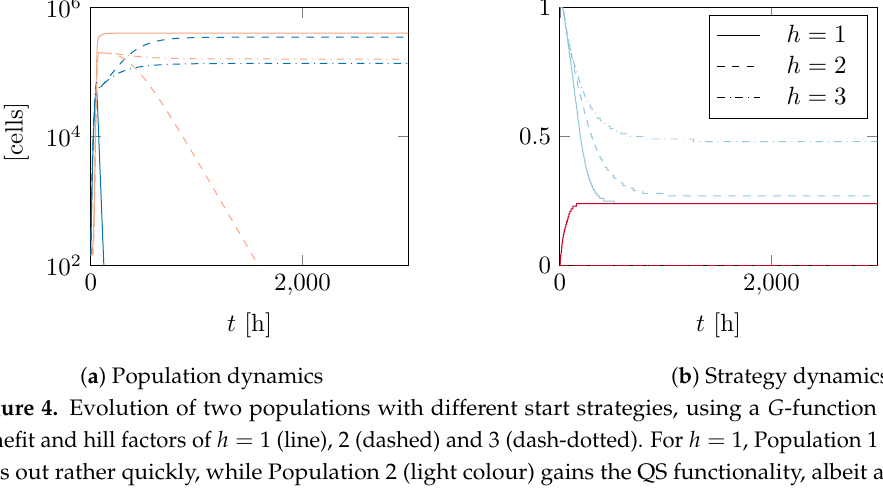
Figure 4. Evolution of two populations with different start strategies, using a G -function with private benefit and hill factors of h = 1 (line), 2 (dashed) and 3 (dash-dotted). For h = 1, Population 1 (dark colour) dies out rather quickly, while Population 2 (light colour) gains the QS functionality, albeit at a low level, and remains at a stable population level. If h = 2, Population 1 reduces its QS strategy to a lower, but stable value. Population 2 is unable to compete and dies out. For h = 3, Populations 1 and 2 coexistt in a stable way with similar numbers. One population is QS active while the other is